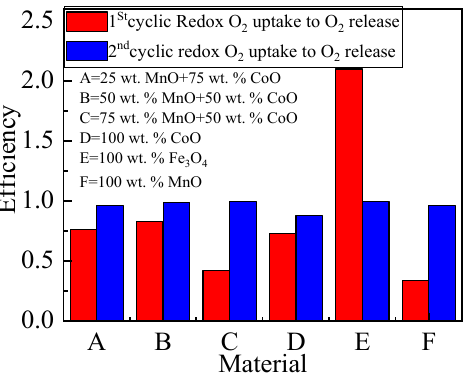
Table 3. The oxygen uptake and release ratio metallic oxides during redox reaction.